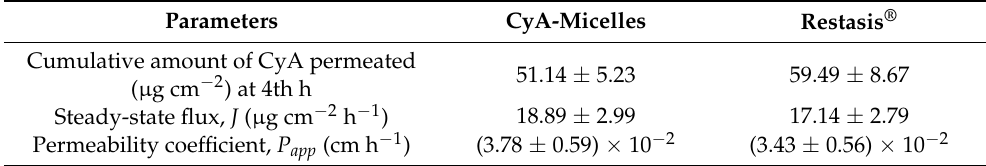
Figure 9. Transcorneal permeation of CyA from Myrj S100- b -PCL 88 micelles and Restasis ® . (Mean ± SD, n = 3). Table 3. Transcorneal permeation parameters for CyA from Myrj S100- b -PCL 88 micelles and Restasis ® (Mean ± SD, n = 3).